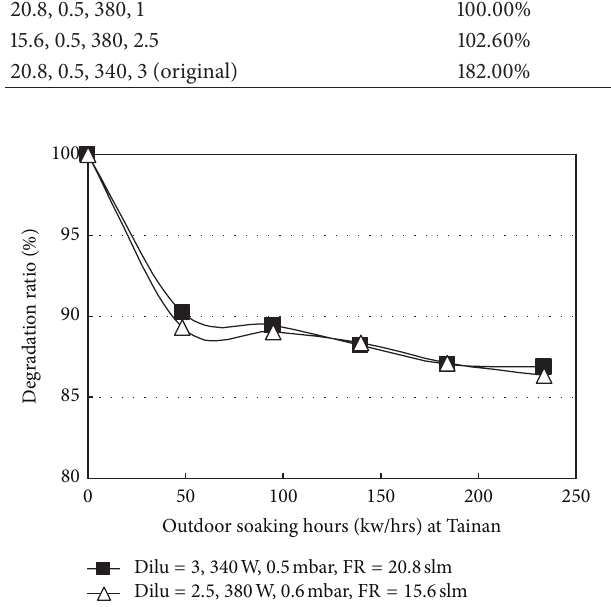
Figure 4: Outdoor soaking results of the fabricated modulates with two kinds of amorphous silicon intrinsic layer after tuning (i.e., Dilu = 2.5 and Dilu =